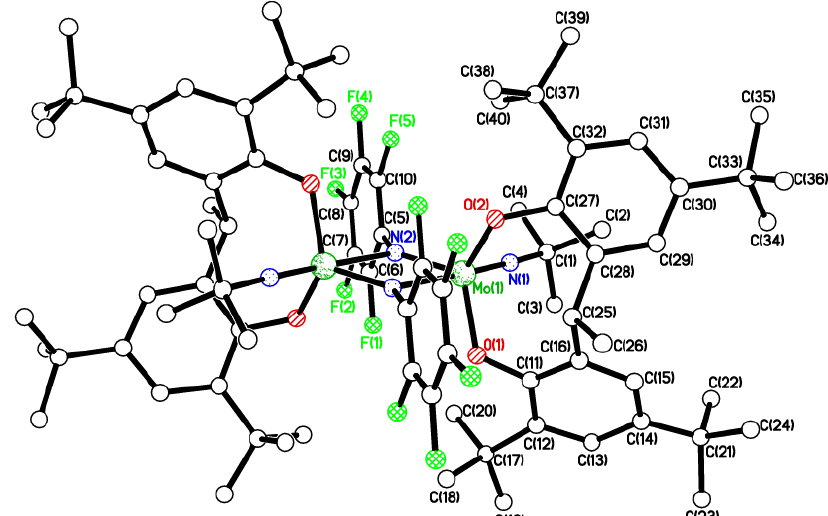
Figure 3. Molecular structure of [Mo(N t -Bu)(NC 6 F 5 )L 1Me ] 2 ( 3 ), showing the atom